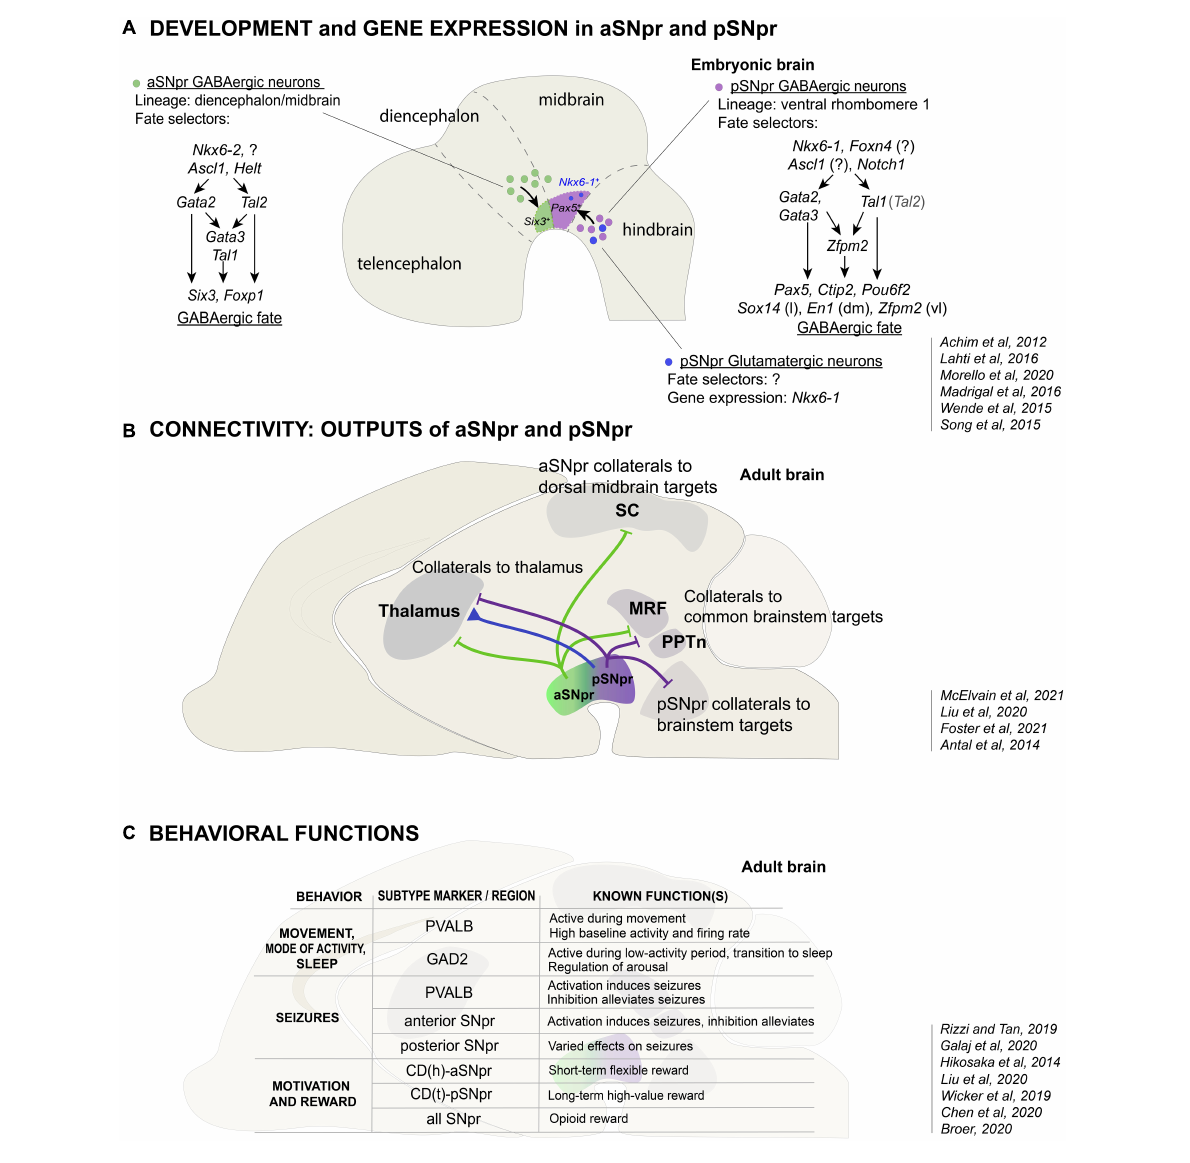
FIGURE2 The development, connectivity and function of the anterior and posterior SNpr neurons. (A) Developmental origin and differential gene expression in the aSNpr GABAergic neurons and the pSNpr GABAergic and glutamatergic neurons. The aSNpr GABAergic neurons originate in the Nkx6-2 expressing neuronal progenitors in the ventrolateral midbrain or posterior diencephalon (green), and are characterized by the expression of Six3 and Foxp1 . aSNpr neurons require the function of the proneural genes Ascl1 and Helt and the selector genes Tal1 and Gata2 in order to acquire GABAergic neuron phenotype. In early precursors, Gata2 and Tal2 are activated independently of each other and can have both common and separate target genes. The pSNpr GABAergic neurons (violet) and glutamatergic neurons (blue) originate in the Nkx6-1 expressing neuronal progenitors in the anterior ventrolateral hindbrain. pSNpr progenitors express Foxn4 , Ascl1 and Notch1 . pSNpr GABAergic neurons are characterized by the expression of Pax5, Ctip2 and Pou6f2 , and require the function of Tal1 and Gata2/Gata3 to acquire GABAergic neuron phenotype. Sox14 , En1 and Zfpm1 expression marks further subtypes of pSNpr neurons, which are located in distinct spatial positions: lateral (l), dorsomedial (dm) or ventrolateral (vl) pSNpr. The transcription factors involved in the fate specification of pSNpr glutamatergic neurons are not known. The relatively minor populations of dopaminergic and cholinergic SNpr neurons are not shown. (B) Differences in the output connectivity of aSNpr and pSNpr neurons. One of the hallmarks of SNpr neurons are the axon-collaterals. The common targets of the aSNpr and pSNpr are thalamus, MRF (midbrain and pontine reticular formation) and PPTn (pedunculopontine nucleus. In addition to projections to the common targets, the aSNpr neuron axon-collaterals (green) project to superior colliculus (SC), while the pSNpr axon-collaterals (violet) more often project to brainstem. Thalamus is one of the major targets of the SNpr glutamatergic neurons (blue). SNpr glutamatergic neurons specifically project to the nucleus reticularis of thalamus (nRT, see text). (C) Variety of functions of the SNpr neuron subtypes. The table summarizes the known functions of the Pvalb - or Gad2 -expressing SNpr GABAergic neurons in the control of motor activity and behavioral state, and the functions of the anterior and posterior parts of the SNpr in the seizure activity, motivation, and reward. How these functions are related to specific molecularly defined SNpr neuron subtypes remains to be